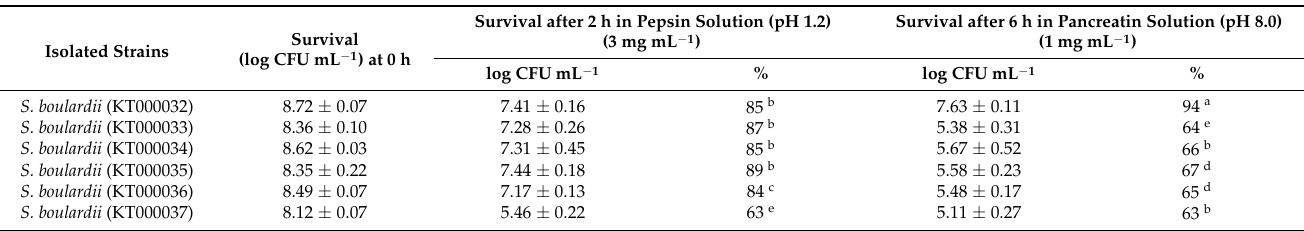
Viability of lactic acid bacteria in the presence of simulated intestinal fluid (pepsin (pH = 1.2) and 1 mg/mL pancreatin in 0.85% NaCl, w / v , pH 8.0). Values are expressed as the mean ± standard deviation ( n = 3). Different superscripts (a, b, c, d, e) represent significantly